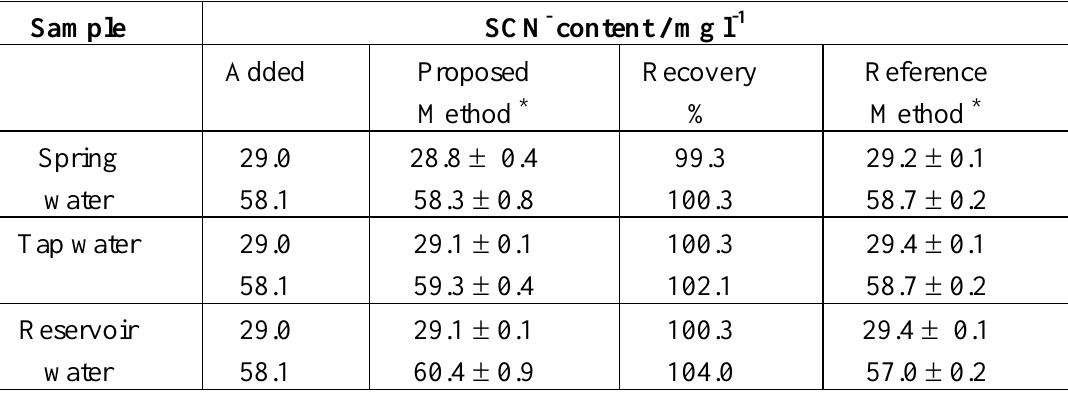
Table 2. Determination of anion thiocyanate in